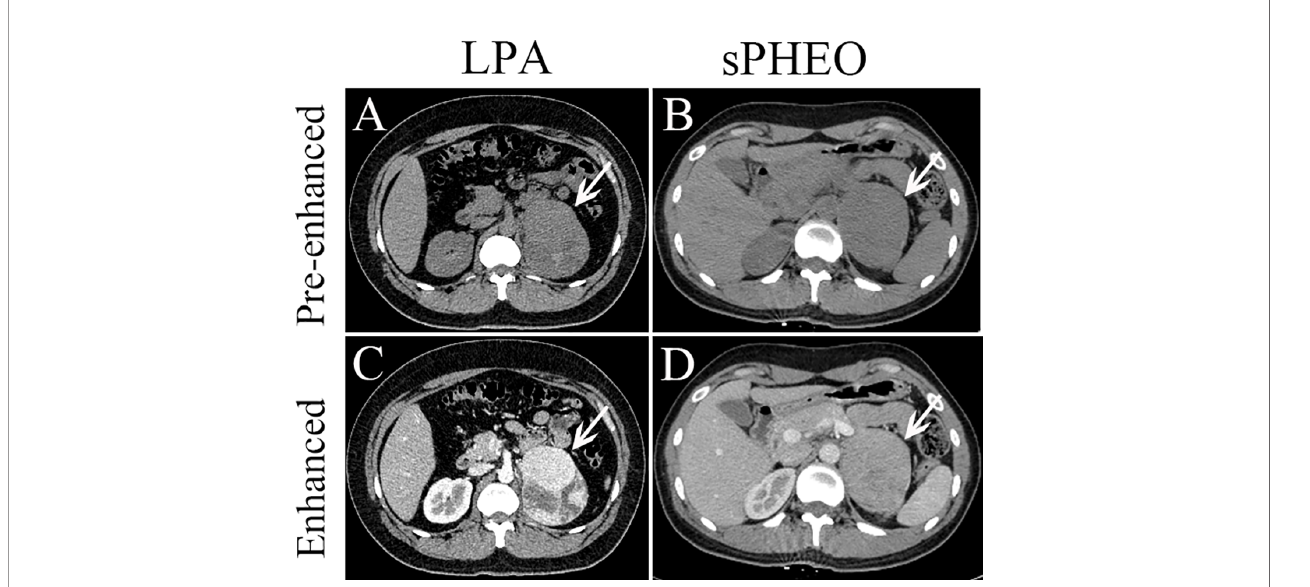
FIGURE 2 | Axial pre-enhanced and enhanced CT images of a patient with lipid-poor adenomas (LPA) (Case 95) and a patient with subclinical pheochromocytoma (sPHEO) (Case 21) showing left adrenal mass at the tumor largest dimensions. On pre-enhanced images, the LPA appeared as an irregular mass with intermediate heterogeneous density (A) , while the sPHEO was an elliptical mass with relatively homogeneous density (B) . After injection of contrast medium (65s), the LPA was markedly more heterogeneous, with obvious cystic and necrotic areas (C) , while the sPHEO showed a mildly heterogeneous enhancement pattern (D)